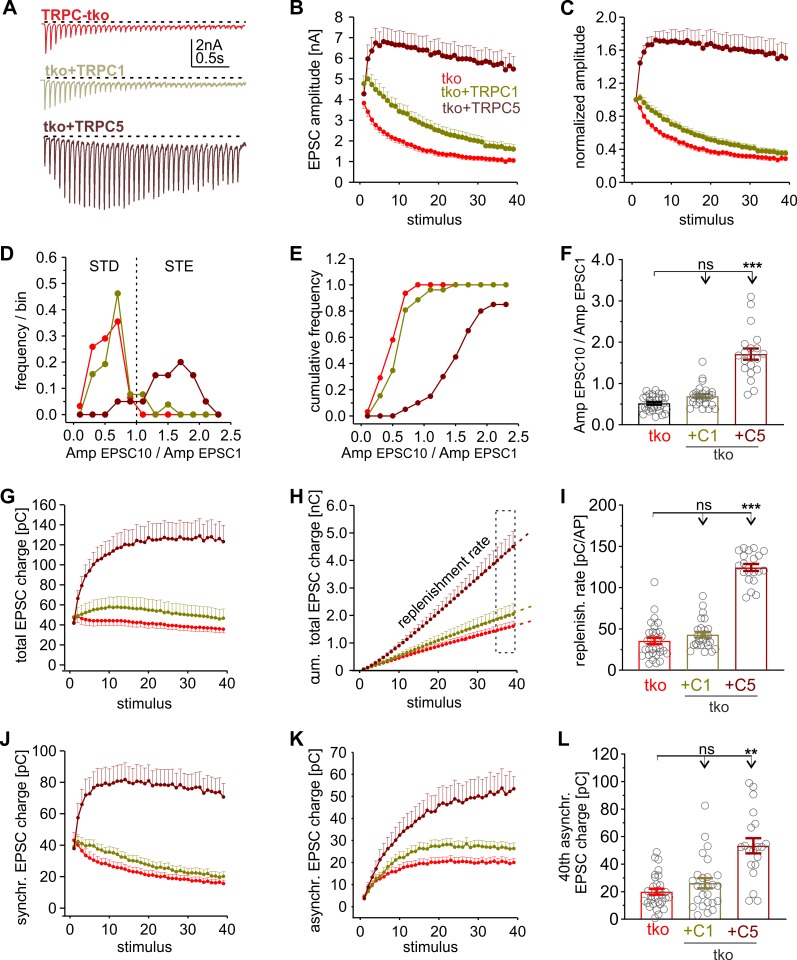
Homomeric TRPC5 channels promote strong STE of synaptic signaling in tko neurons.(A) Sample recordings of EPSCs triggered by HFS (20 Hz, 40 AP/2 s) of tko neurons and those expressing C1 or C5. (B) Starting from similar initial EPSC amplitudes, only TRPC5 expression causes STE of the synaptic response. (C) EPSC amplitude changes during HFS normalized to the amplitude of the first response. (D–F) The AmpEPSC10/AmpEPSC1 ratio of TRPC5-expressing tko neurons is shifted to the STE range and nearly 3-fold higher compared with tko and tko + C1 responses (panel F, +C1, p = 0.14; +C5, p = 1.9 × 10−10, versus tko). (G–I) TRPC5, but not TRPC1, expression elevates the total synaptic charge transfer and increases the replenishment rate (+C1 p = 0.1; +C5, p = 2 × 10−10, versus tko). (J and K) Time courses of synchronous (J) and asynchronous charge transfer (K) during the stimulus train. (L) The 40th asynchronous charge is significantly increased with TRPC5 expression (+C1, p = 0.98; +C5, p = 0.000005; versus tko). Data were collected from the following number of neurons: tko, n = 31; tko + TRPC1, n = 26; tko + TRPC5, n = 20; **p < 0.01, ***p < 0.001; one-way ANOVA on ranks followed by Dunn’s post hoc test. Underlying data can be found in S1 Data. Amp, amplitude; AP, action potential; EPSC, evoked postsynaptic current; HFS, high-frequency stimulation; ns, not significant; STD, short-term depression; STE, short-term enhancement; tko, triple knockout; TRPC, transient receptor potential canonical.